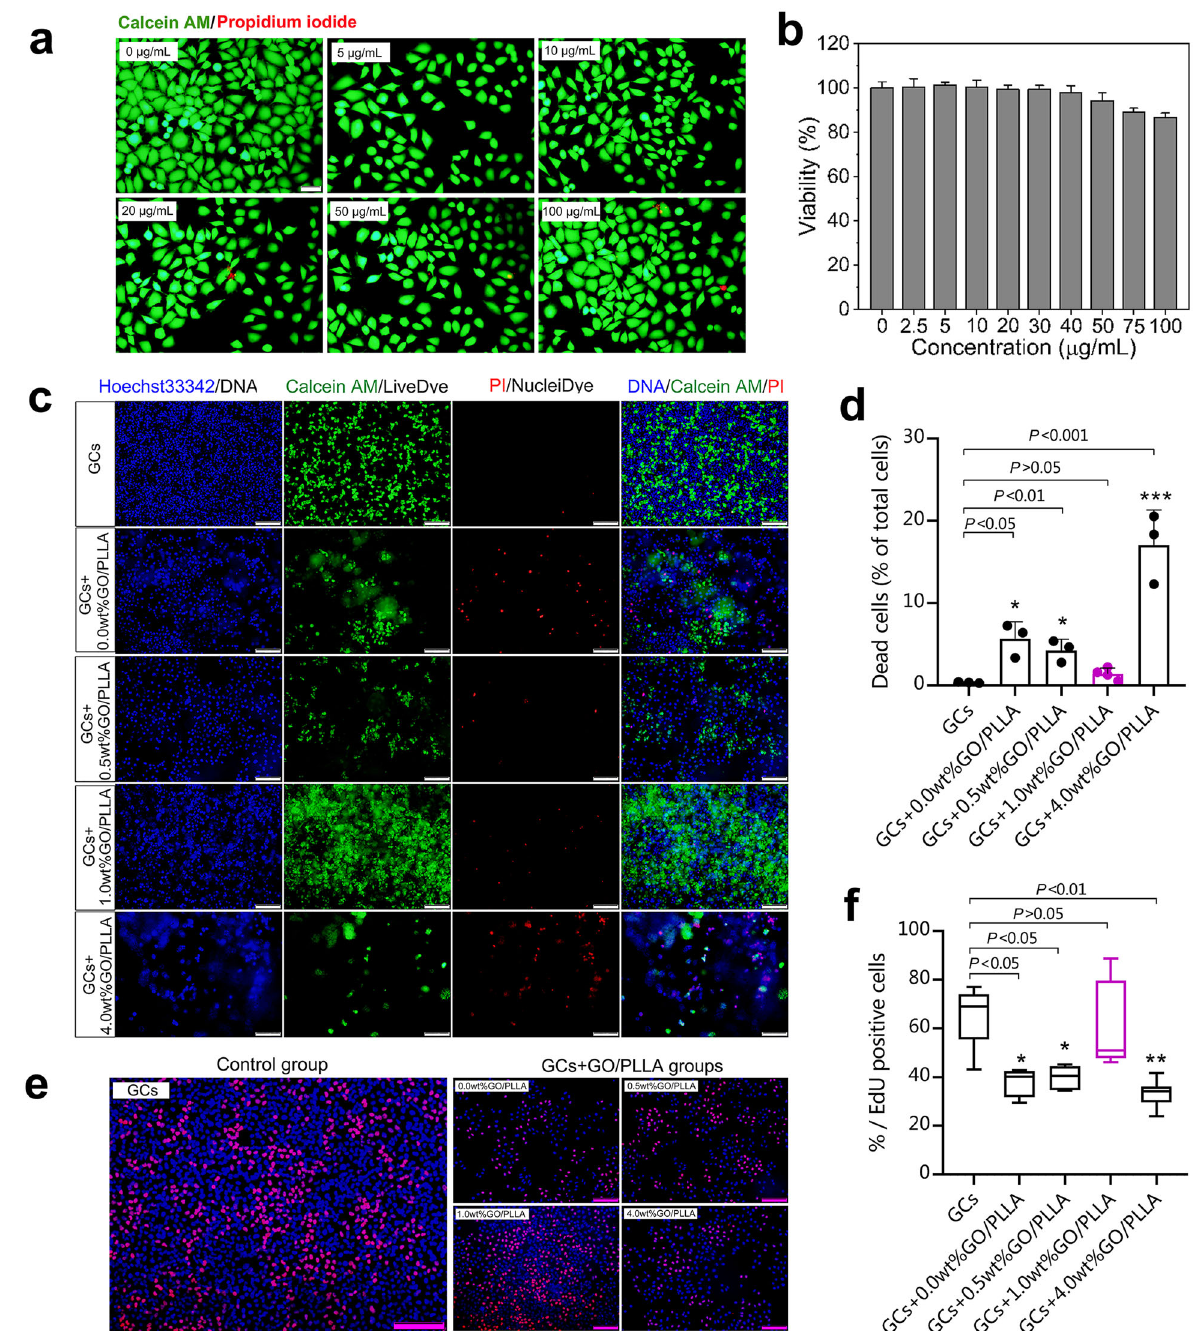
Fig. 2 Cytotoxicity assessment of GO nanosheets and the optimization of GO concentration in GO/PLLA nano fi ber scaffolds. a The most representative image of Live-Dead staining of GCs with GO nanosheets at various concentrations. Scale bar: 50 μ m. b Cell viability of GCs treated with GO nanosheets at various concentrations. c Live-Dead fl uorescence staining images of GCs polymerized with different GO/PLLA nano fi ber scaffolds. Scale bar: 200 μ m. Blue: nucleus; Green: cytoplasmic orthoesterase activity (live cells); Red: damaged cell membranes allow ethidium homodimer to bind to DNA (dead cells). d The dead cells ratio (% of the total cells) after culturing for 72 h. e The most representative images of the EdU assay of GCs with GO nanosheets at various concentrations. Scale bar: 200 μ m. f The percentage of EdU-positive cells after culturing for 72 h. Statistical signi fi cance levels are set at * P < 0.05, ** P < 0.01, ** *P < 0.001 by one-way ANOVA (Multiple comparisons). Data are presented as mean ±